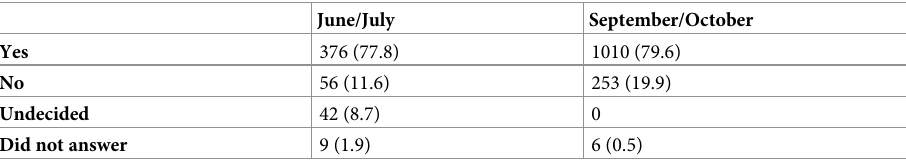
Table 2. Willingness to take COVID-19